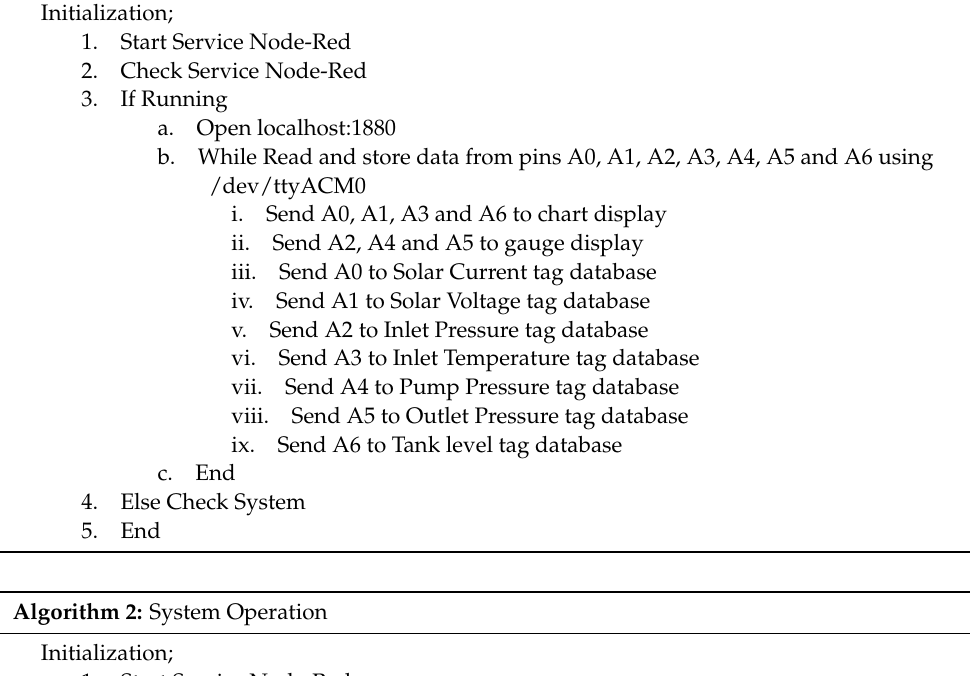
Algorithm 1: Field Sensor Data Acquisition, Storage, and